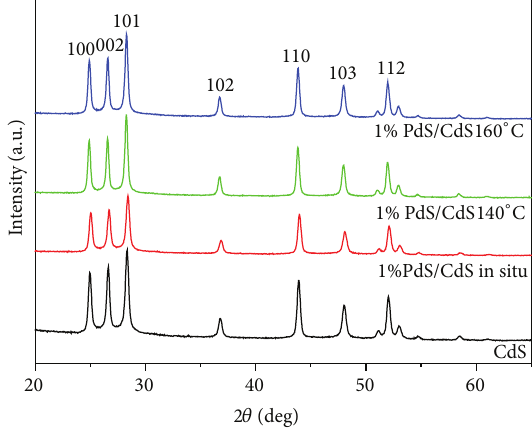
Figure 4: UV-visible absorption spectra of CdS and PdS/CdS samples.